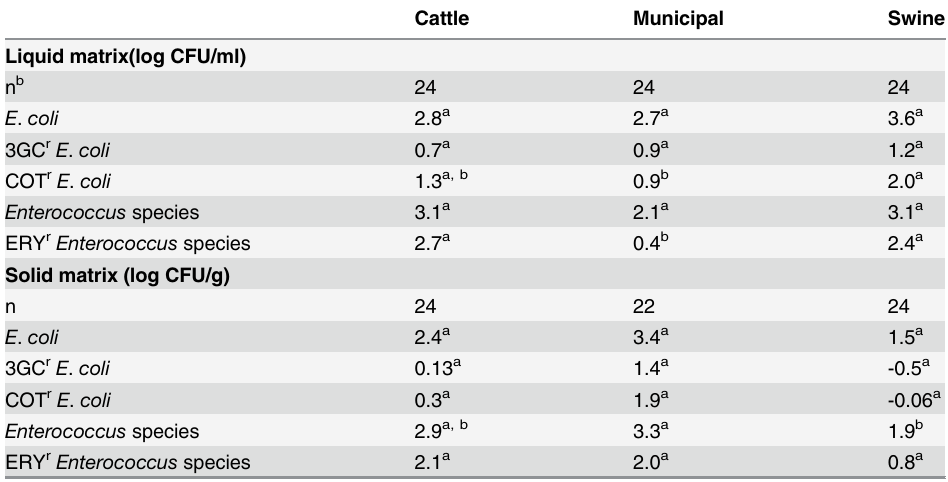
a Different superscripts across rows indicate statistically signi fi cant ( P < 0.05) differences between pair of sample sources. Bonferroni adjusted for multiple comparisons. b Abbreviations: n = number of samples; 3GC r = third generation cephalosporin resistant; COT r = trimethoprim/sulfamethoxazole resistant; ERY r = erythromycin resistant.